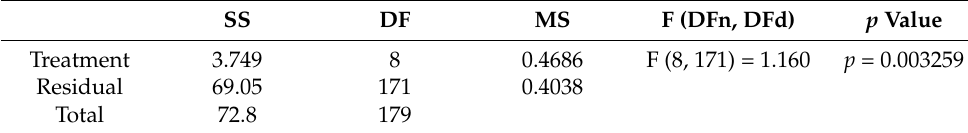
Table 21. ANOVA test of the fitness of the proposed ADSCFGWO algorithm.